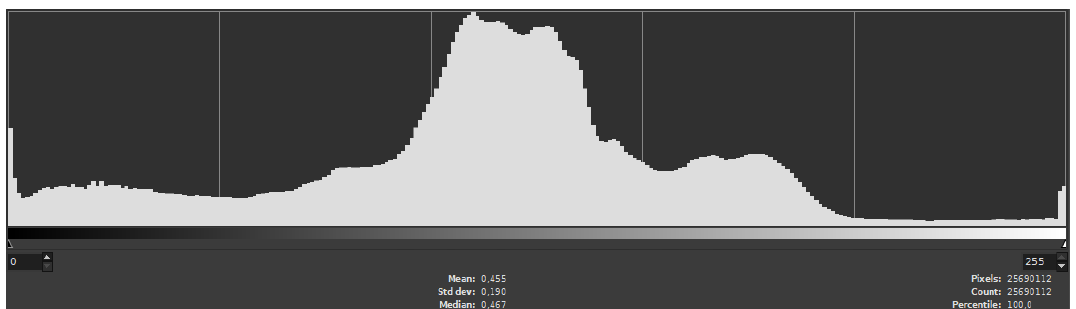
Figure 4. Greyscale conversion.